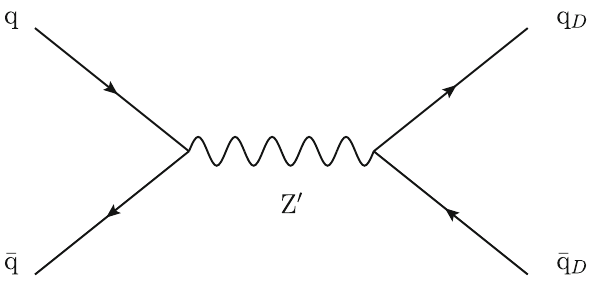
Fig. 1 Diagram for the pair production of dark quarks through a Z (cid:7) portal